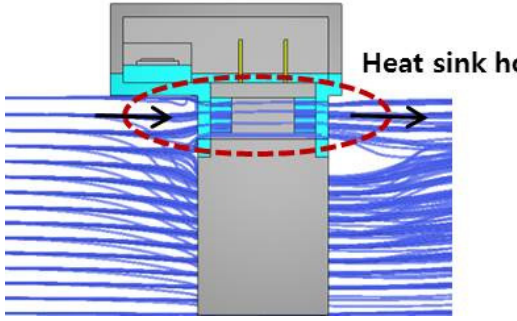
Figure 8. Flow line at the heat sink hole of the heating system controller.